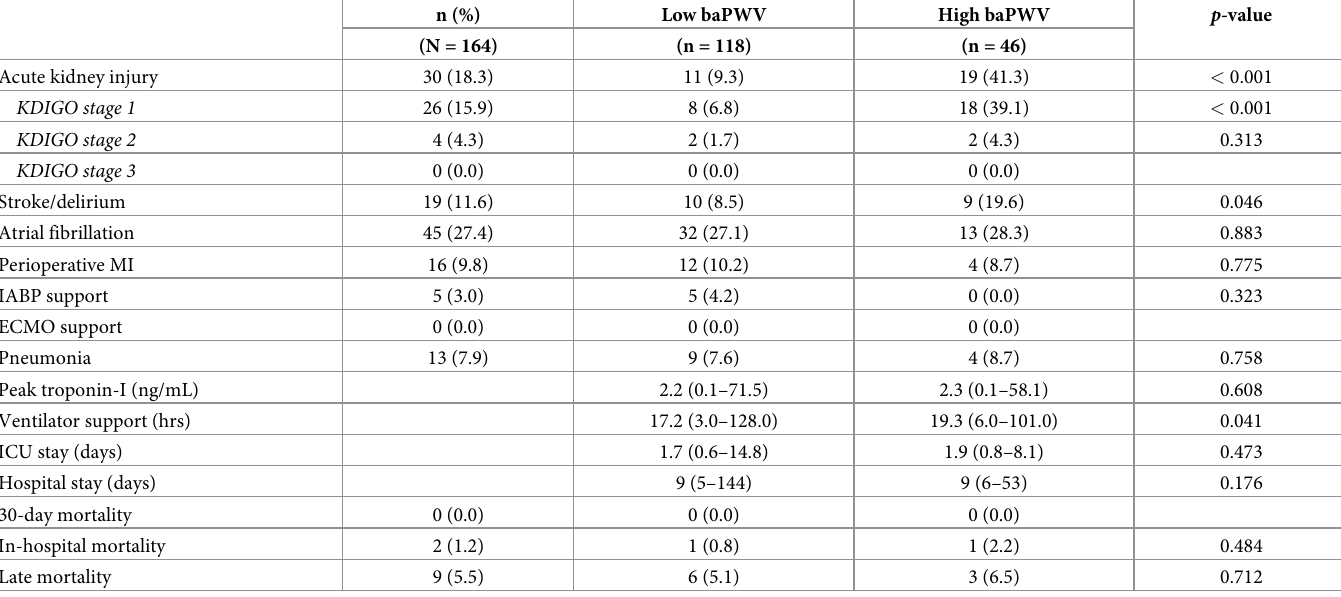
The optimal baPWV cut-off value for predicting AKI was determined as 18.2 m/s from the ROC analysis. Thus, 19 m/s was stated as the dividing point between designations of “high” and “low” for PWV values for each investigative group. When comparing postoperative com- plications, as demonstrated in Table 4, AKI developed more frequently among patients in the high PWV group (41.3%, n = 19 vs. 9.3%, n = 11, p < 0.001) despite the fact that preoperative creatinine levels of the high PWV group was not statistically different from those of the low PWV group, and preoperative median eGFR value of the high PWV group was 75.7 mL/min/ 1.73 m 2 which was not bad. There was no patient who required renal replacement therapy in patients with postoperative AKI though. For further details about comparison of baseline char- acteristics between the high and the low baPWV groups, please see supplementary material (S1 Table). Similarly, the composite incidence of stroke and delirium (composite neurologic Table 4. Inter-group comparison of postoperative complications and